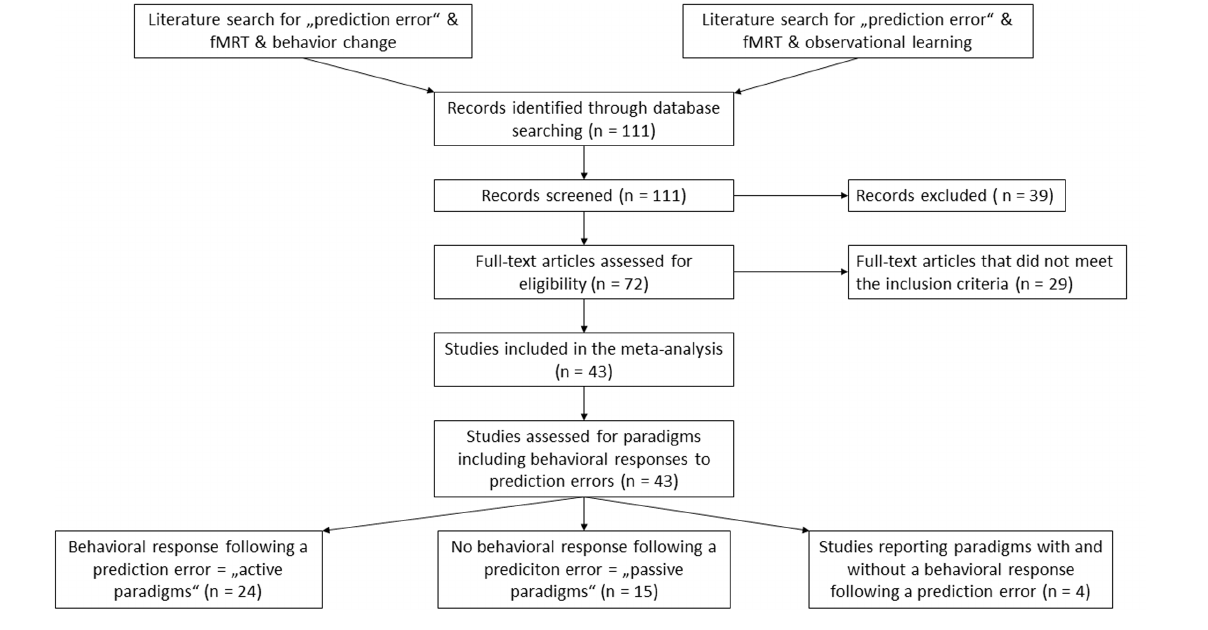
FIGURE 1 | Overview of the literature selection